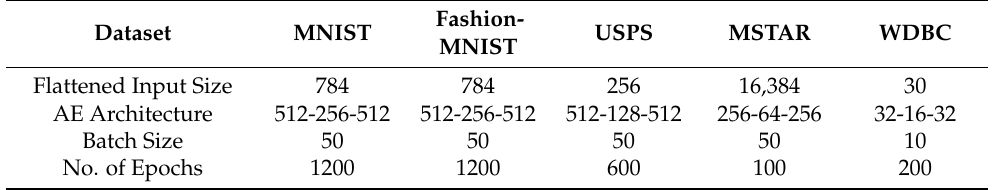
Table 2. Autoencoder architecture, batch sizes and number of epochs for each